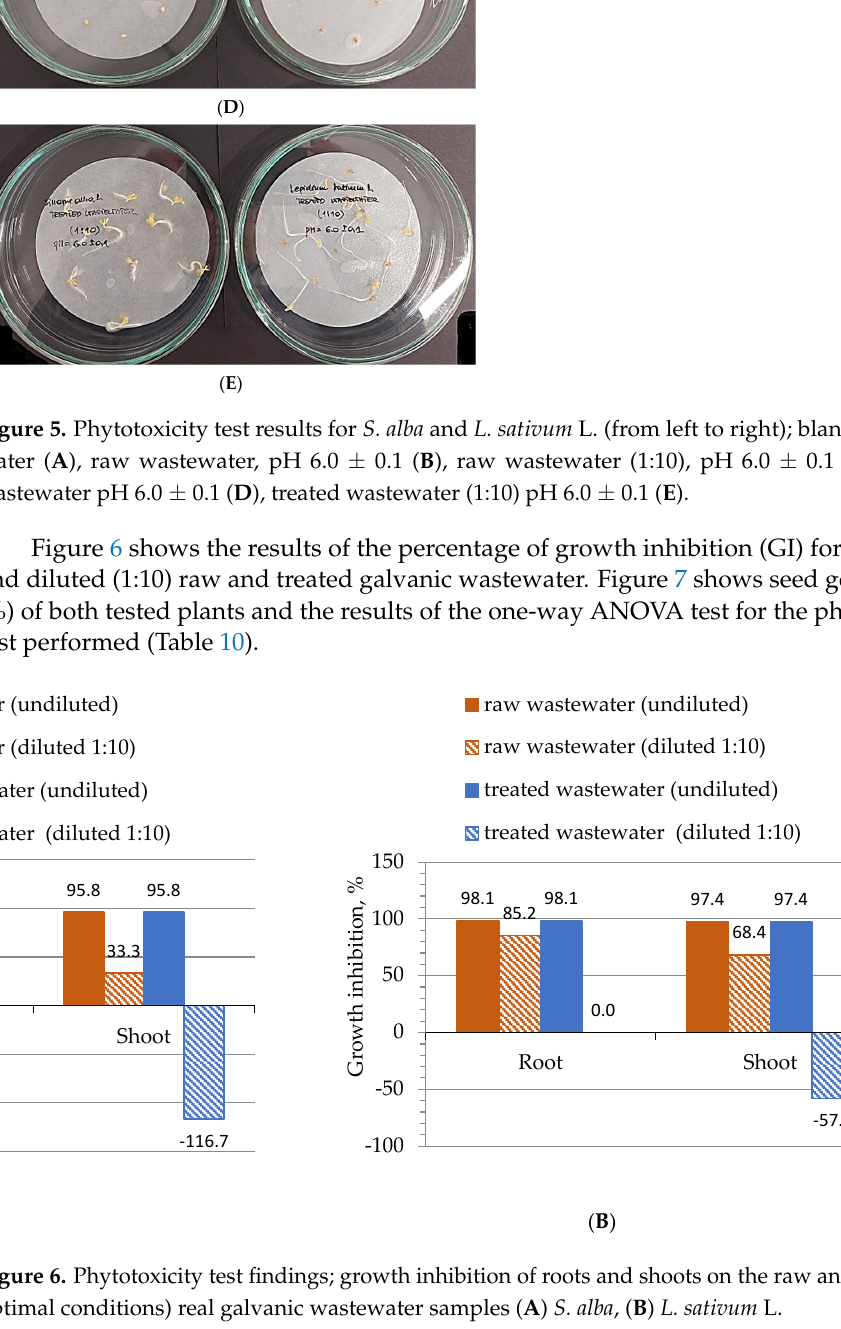
Table 10. Results of one-way ANOVA test for phytotoxicity tests. Tasted